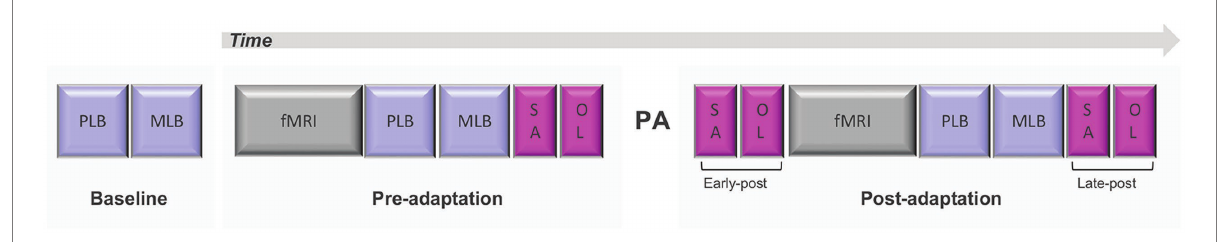
FIGURE 1 Experimental design. PLB, perceptual line bisection; MLB, manual line bisection; SA, straight-ahead pointing; OL, open-loop pointing; PA, prism adaptation. Adapted from Schintu et al.